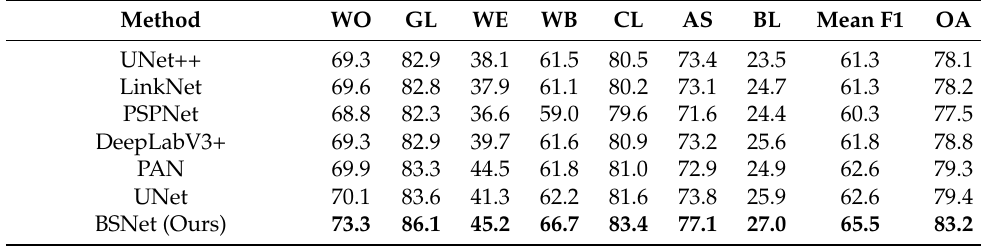
Table 5. Accuracy comparison between our BSNet and other methods on the Landsat extend